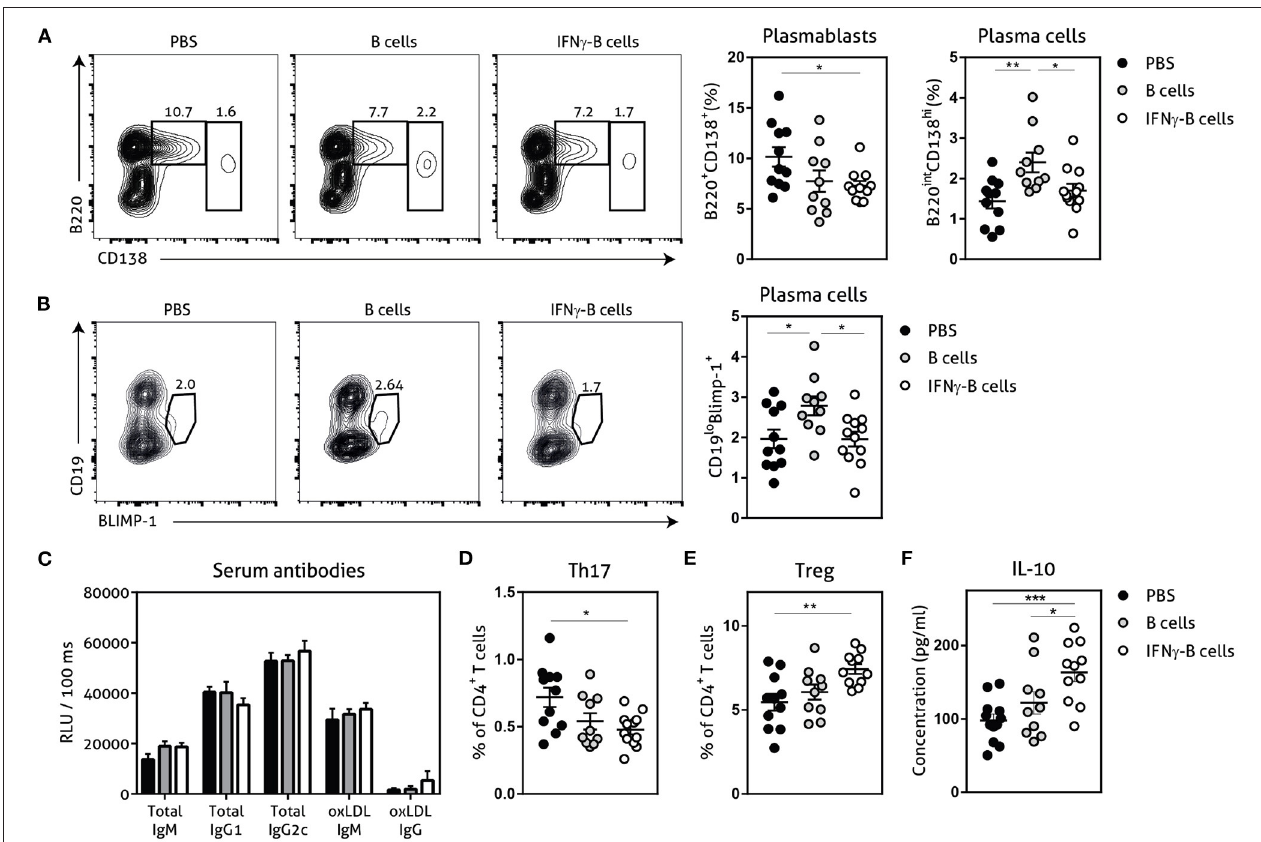
FIGURE 4 | Effects of adoptive transfer of IFN γ -B cells on the humoral immunity. ApoE − / − mice were fed a Western type diet for 7 weeks. After 2 weeks they received a perivascular collar and were treated with PBS, freshly isolated B cells (B cells) or B cells stimulated with 20.0ng/ml IFN γ for 24h (IFN γ -B cells). Mice received a total of three injections and injections were spaced every two weeks. After 7 weeks, mice were sacrificed and spleens were analyzed with flow cytometry. (A) Flow charts and quantification of plasmablasts (B220 + CD138 + ) and plasma cells (B220 lo CD138 hi ). (B) Flow charts and quantification of CD19 lo BLIMP-1 + plasma cells. (C) Serum was analyzed for circulating antibodies by ELISA. Spleens were analyzed with flow cytometry for (D) Th17 cells (RORyt + ) or (E) Treg cells (FoxP3 + ). (F) Splenocytes were isolated and stimulated with anti-CD3 (1 µ g/ml) and anti-CD28 (0.5 µ g/ml) for 72h after which supernatant was collected and analyzed for cytokine expression with a multiplex analysis. Quantification of IL-10 concentration is shown. Data are analyzed with a One-Way ANOVA and shown as mean ± SEM (* p < 0.05, ** p < 0.01). n = 10–12/group, *** p <